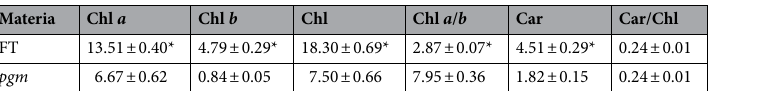
Table 1. Content of photosynthetic pigments of leaves in pale green mutant ( pgm ) and wild-type (FT). The t-test with paired comparison was used to test the significant differences between the wild-type FT and pale green mutant ( pgm ). The ‘*’ followed by figures represents significant differences at 5%